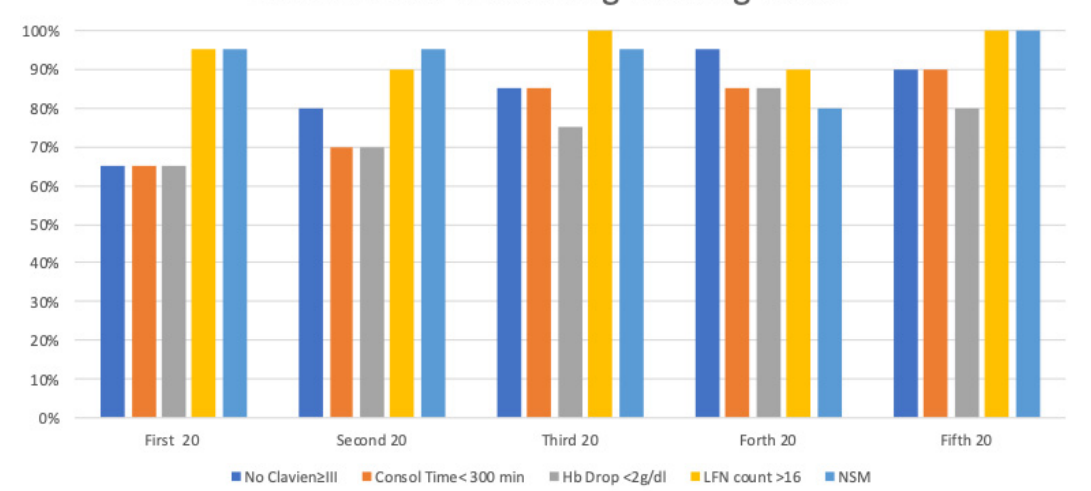
Figure 3. Learning curve according to pentafecta.